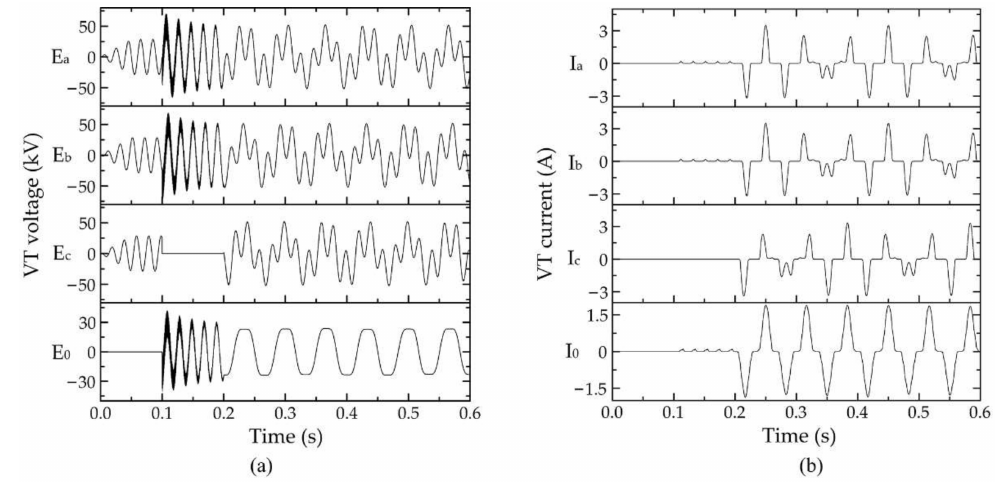
Figure 5. Ferromagnetic resonance waveform at 35 kV. ( a ) Voltage of VT; ( b ) current of